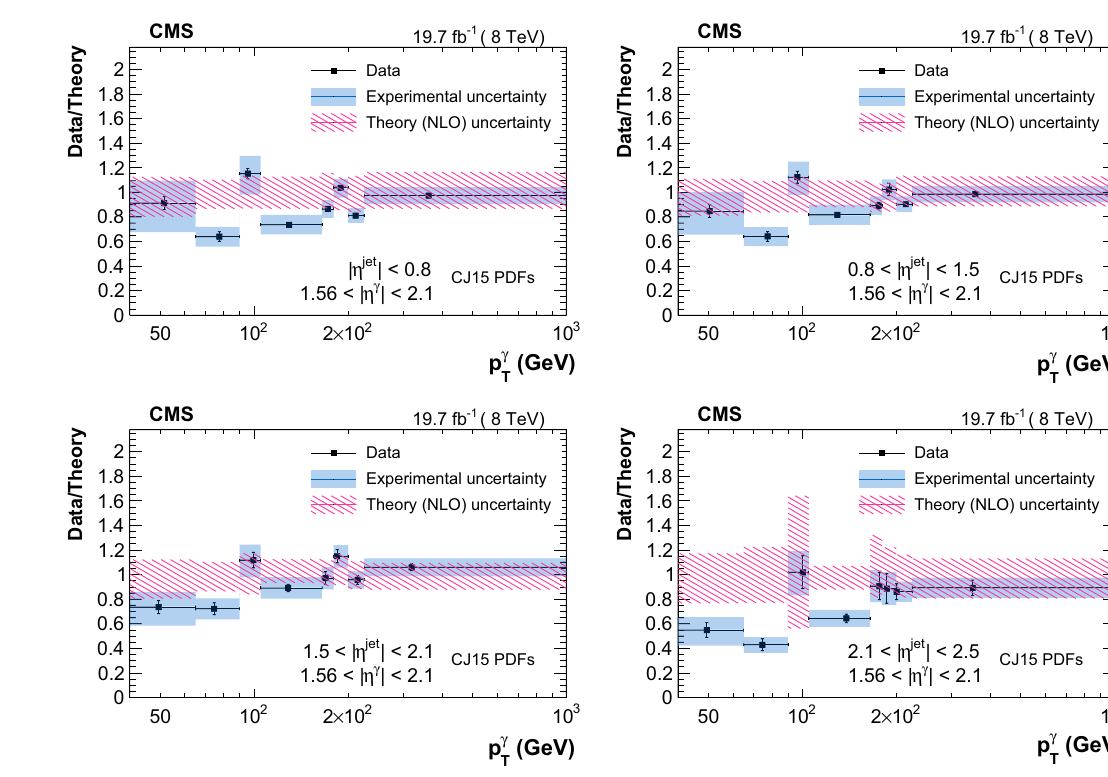
Fig. 7 Ratio of triple-differential cross sections as a function of p measured in data over the corresponding GamJet NLO theoretical pre- diction (obtained with the CJ15 PDFs) in different bins of | η jet | for